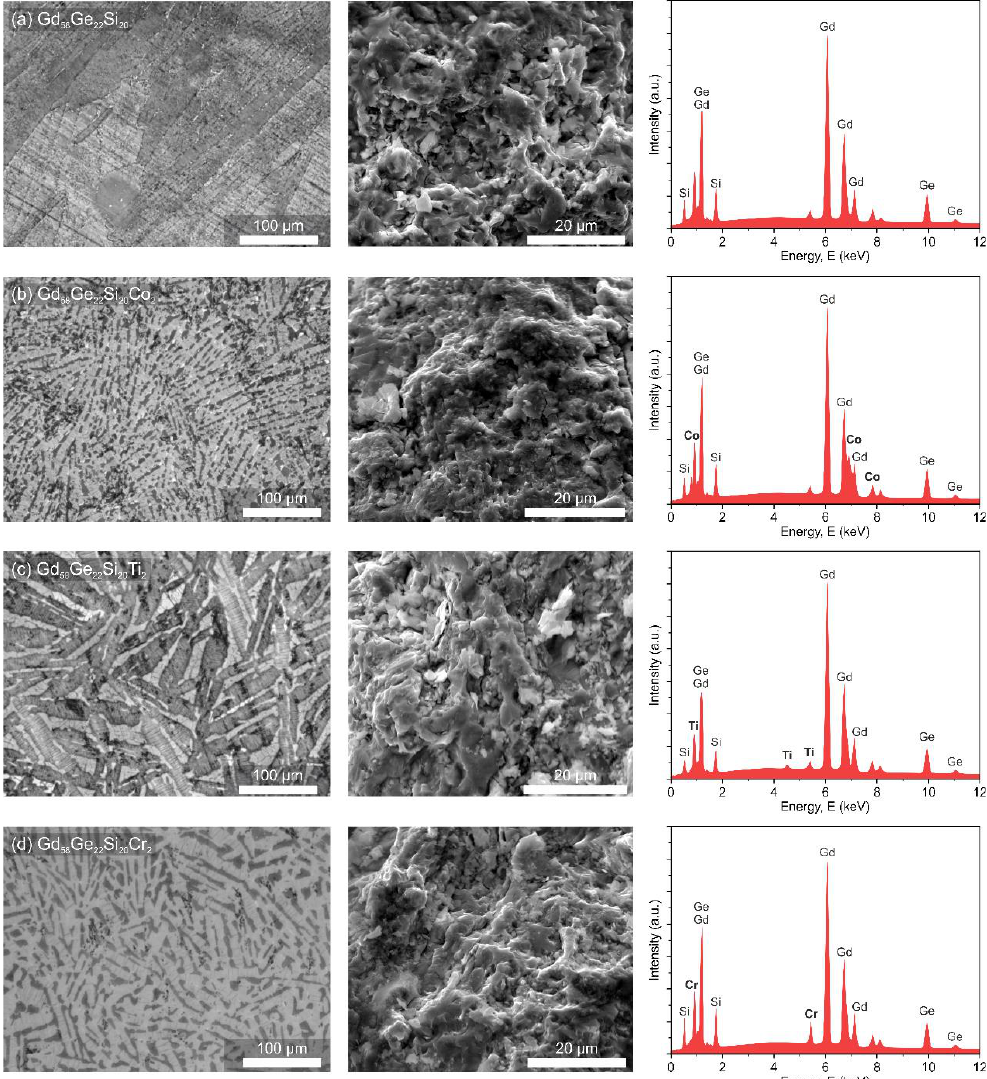
Figure 2. Optical microscopy images (left column), SEM / SE fracture images (middle column) and corresponding EDS spectra (right column) for the annealed Gd 58 Ge 20 Si 22 ( a ), Gd 56 Ge 20 Si 22 Co 2 ( b ), Gd 56 Ge 20 Si 22 Ti 2 ( c ) and Gd 56 Ge 20 Si 22 Cr 2 ( d ) alloys.